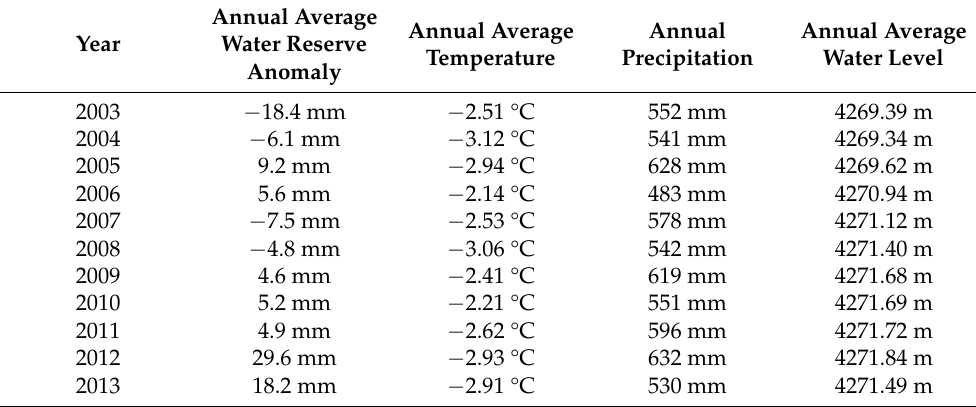
Table 3. Climatic factors at the source of the Yellow River and changes in the average annual water level of Ngoring Lake during the period